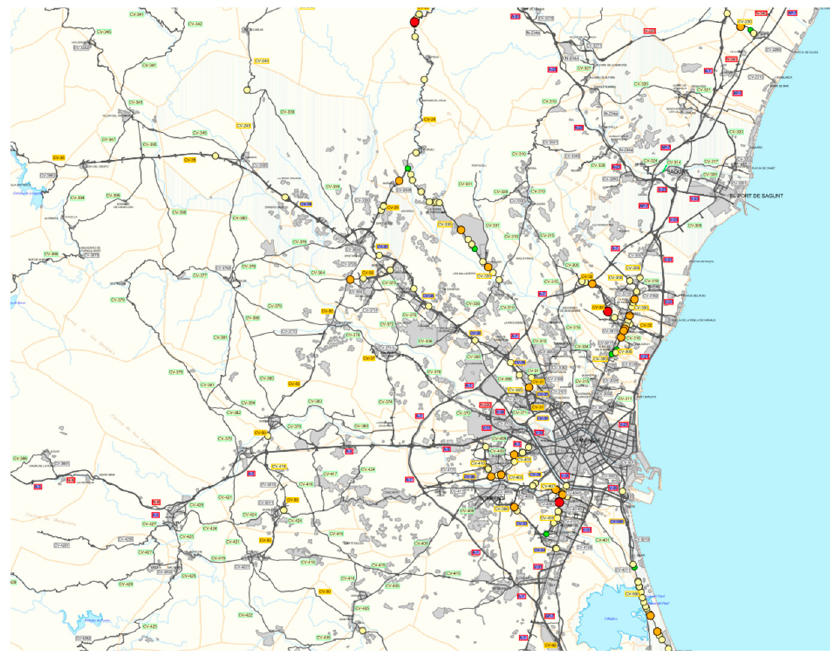
Figure 8. Road accidents involving cyclists (2012–2016). Each circle corresponds to one crash (green: PDO crash, yellow: slight injury crash, orange: serious injury crash, red: fatal crash). Source: General Directorate of Public Works and Transportation of the Valencian Government.